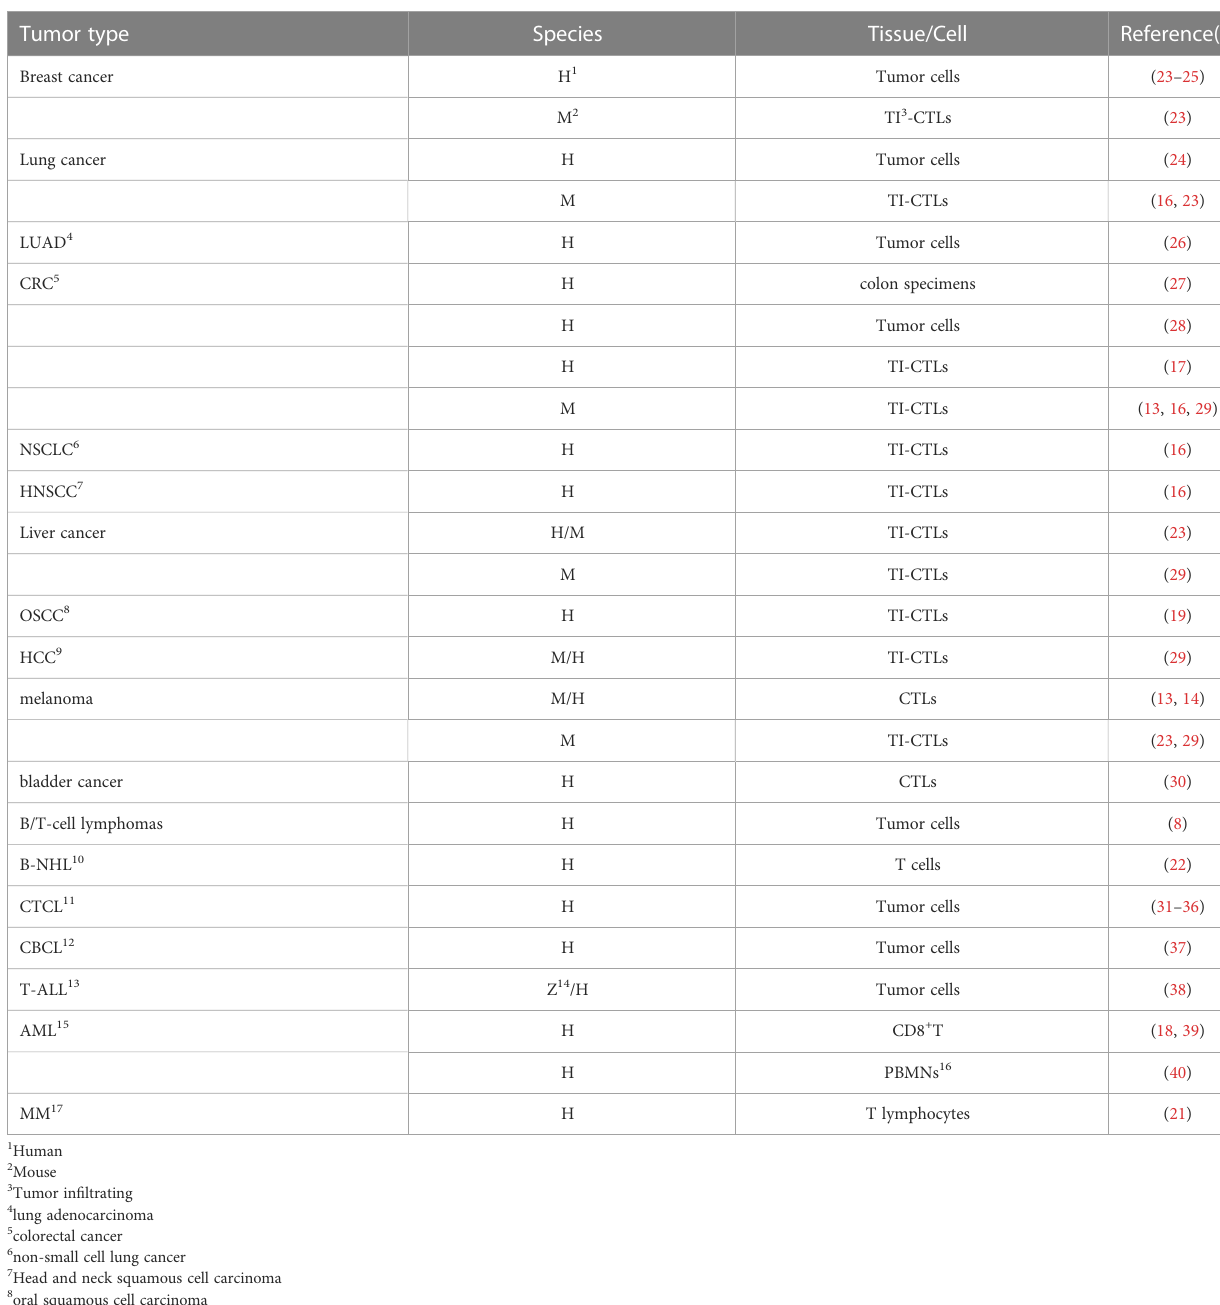
TABLE 1 TOX is intrinsically and extrinsically involved in